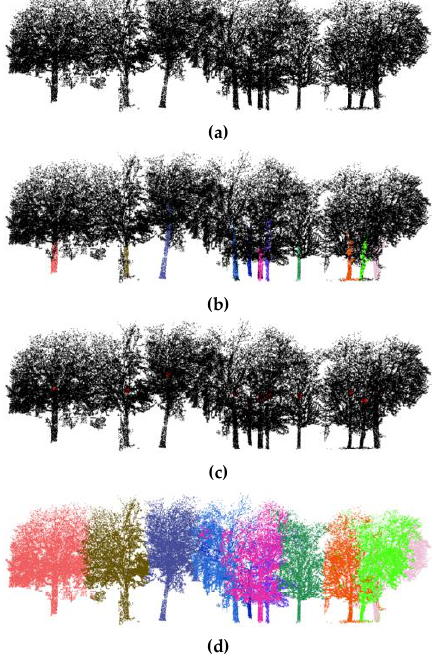
Figure 10. Individual tree extraction process of Scene 1, Scene 2 and Scene 3. ( a ) The PCD of trees. ( b ) Trunk extraction results. ( c ) Crown center extraction results. ( d ) Individual tree extraction re- sults.